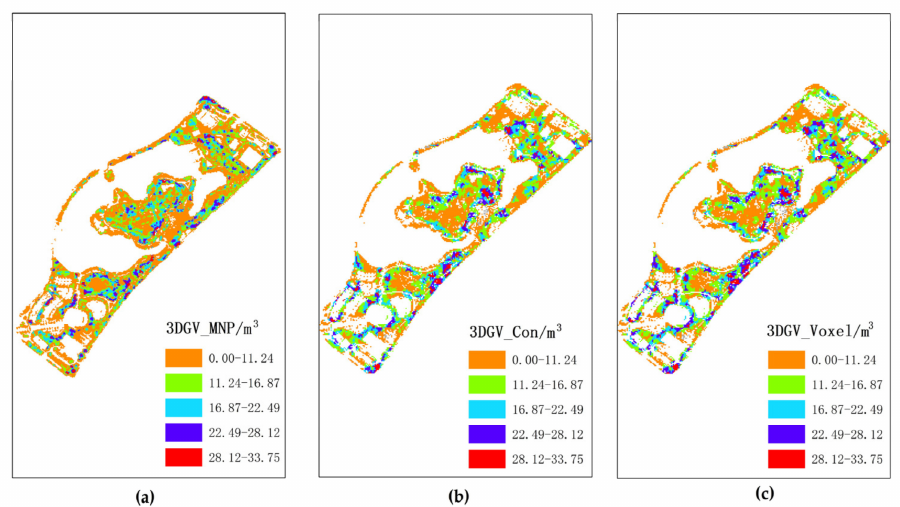
Figure 11. The 3DGV maps: ( a ) The results of the MNP algorithm; ( b ) the results of the Convex hull algorithm; ( c ) the results of the Voxel algorithm.